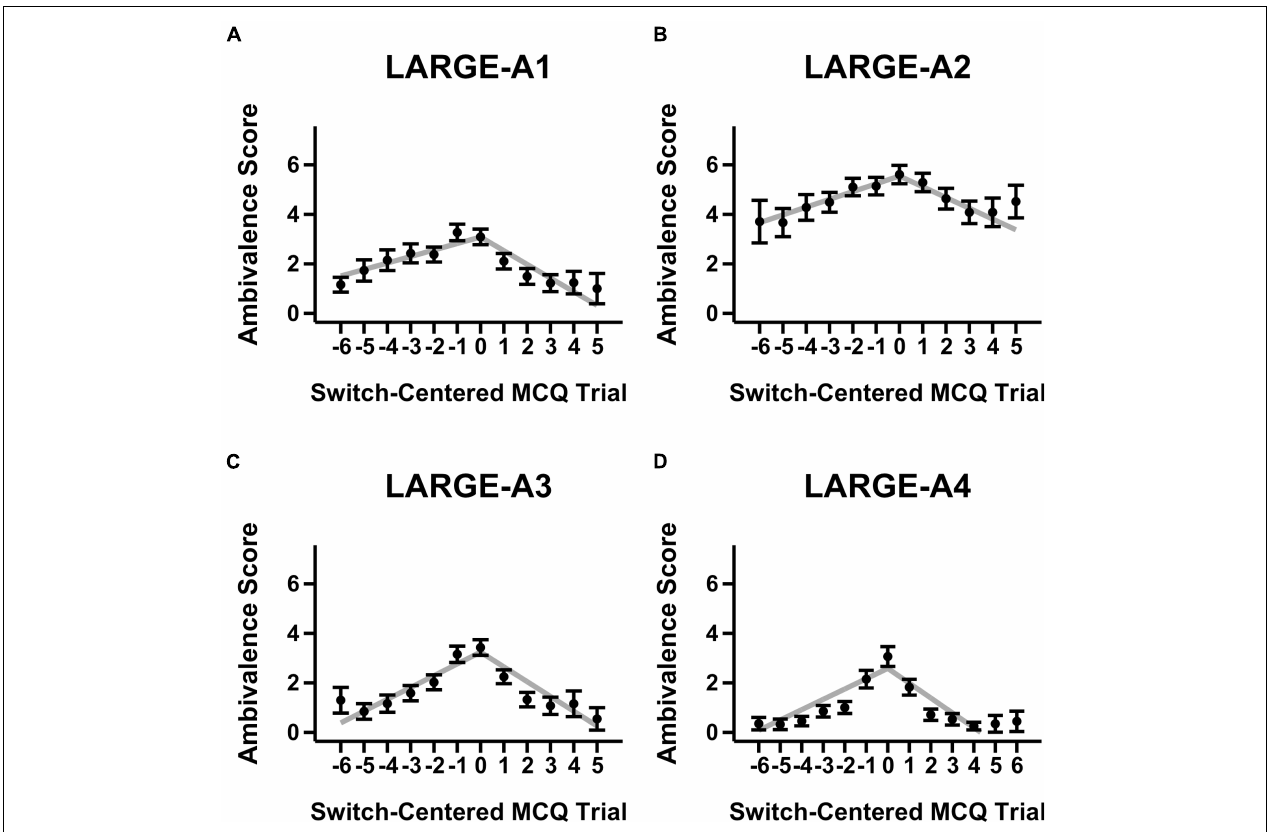
FIGURE 2 | Mean ambivalence scores and dual-slopes mixed model predictions for large magnitude trials split by ambivalence measurement condition. X-axis denotes the MCQ trial number centered by switch trial, Y-axis denotes the degree of ambivalence, and the panels denote the specific magnitude-ambivalence pairing: (A) Large-A1; (B) Large-A2; (C) Large-A3; (D) Large-A4. Black points indicate the trial-level means in self-reported ambivalence scores with standard error bars. Gray lines indicate the predicted ambivalence scores from the dual-slopes mixed